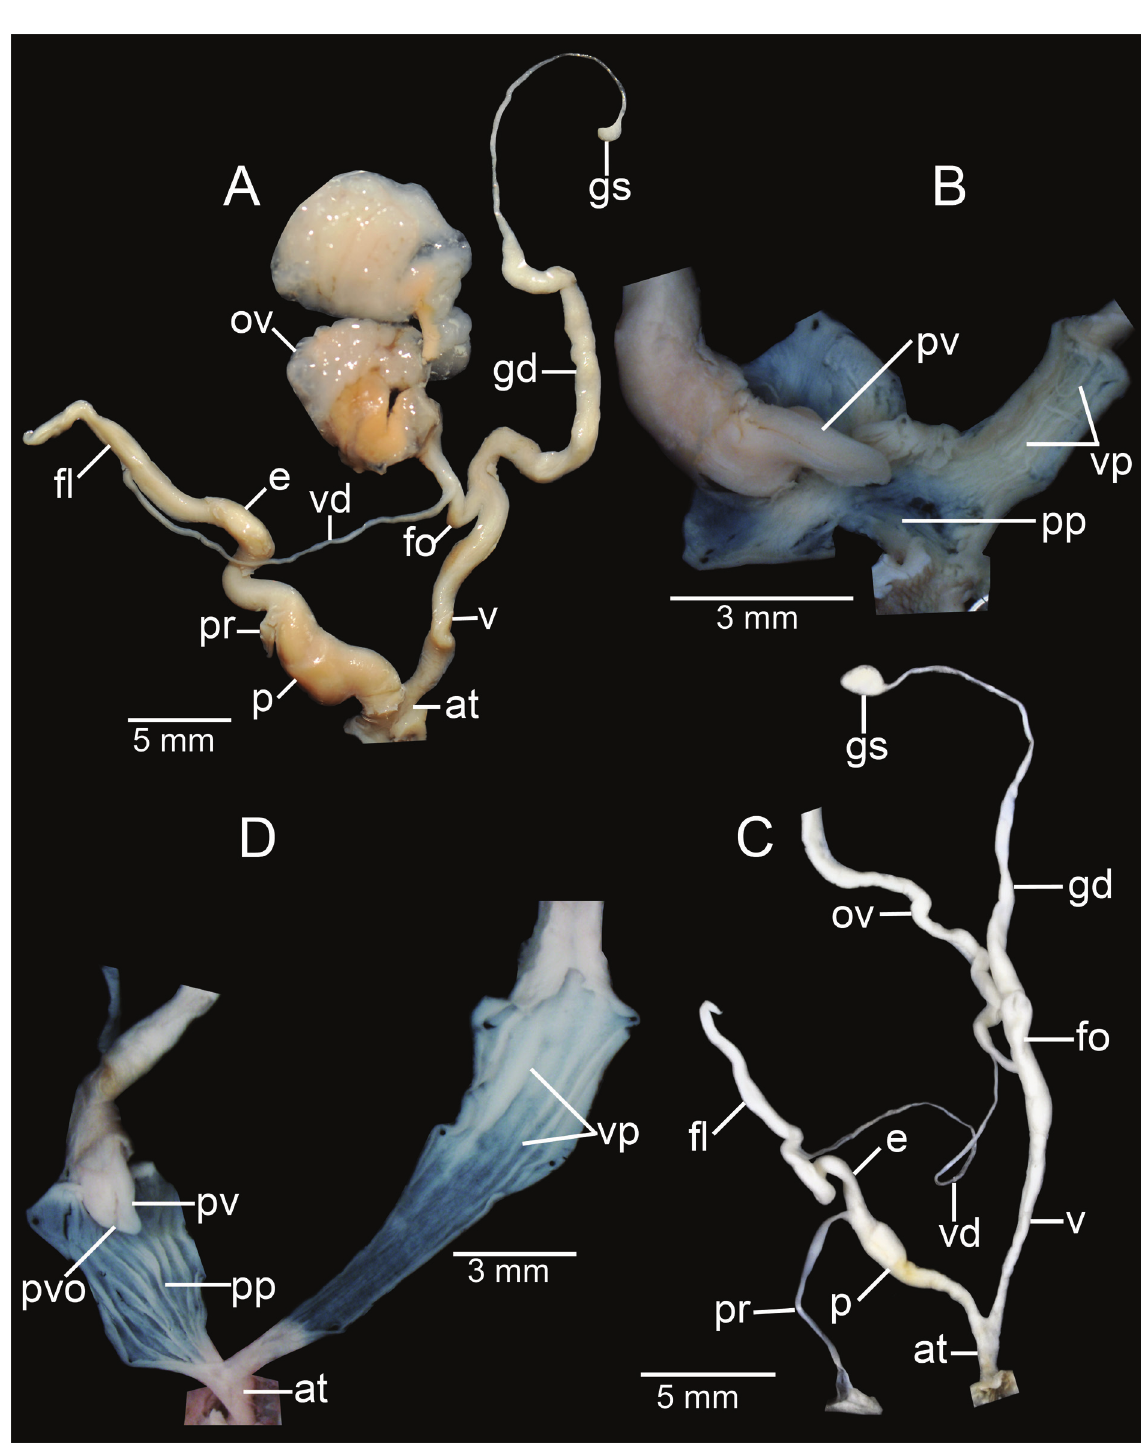
Fig. 14. Genitalia of Amphidromus ( Syndromus ) spp. A–B . Amphidromus xiengensis Morlet, 1891 from Luang Phrabang showing the reproductive system and interior structures of the penis and vaginal chamber (CUMZ 7035). C–D . Amphidromus fuscolabris Möllendorff, 1898 from Ban Phone, Sekong, Laos showing the general characteristics of the genital system and the interior structures of the penis, atrium and vaginal chamber (CUMZ